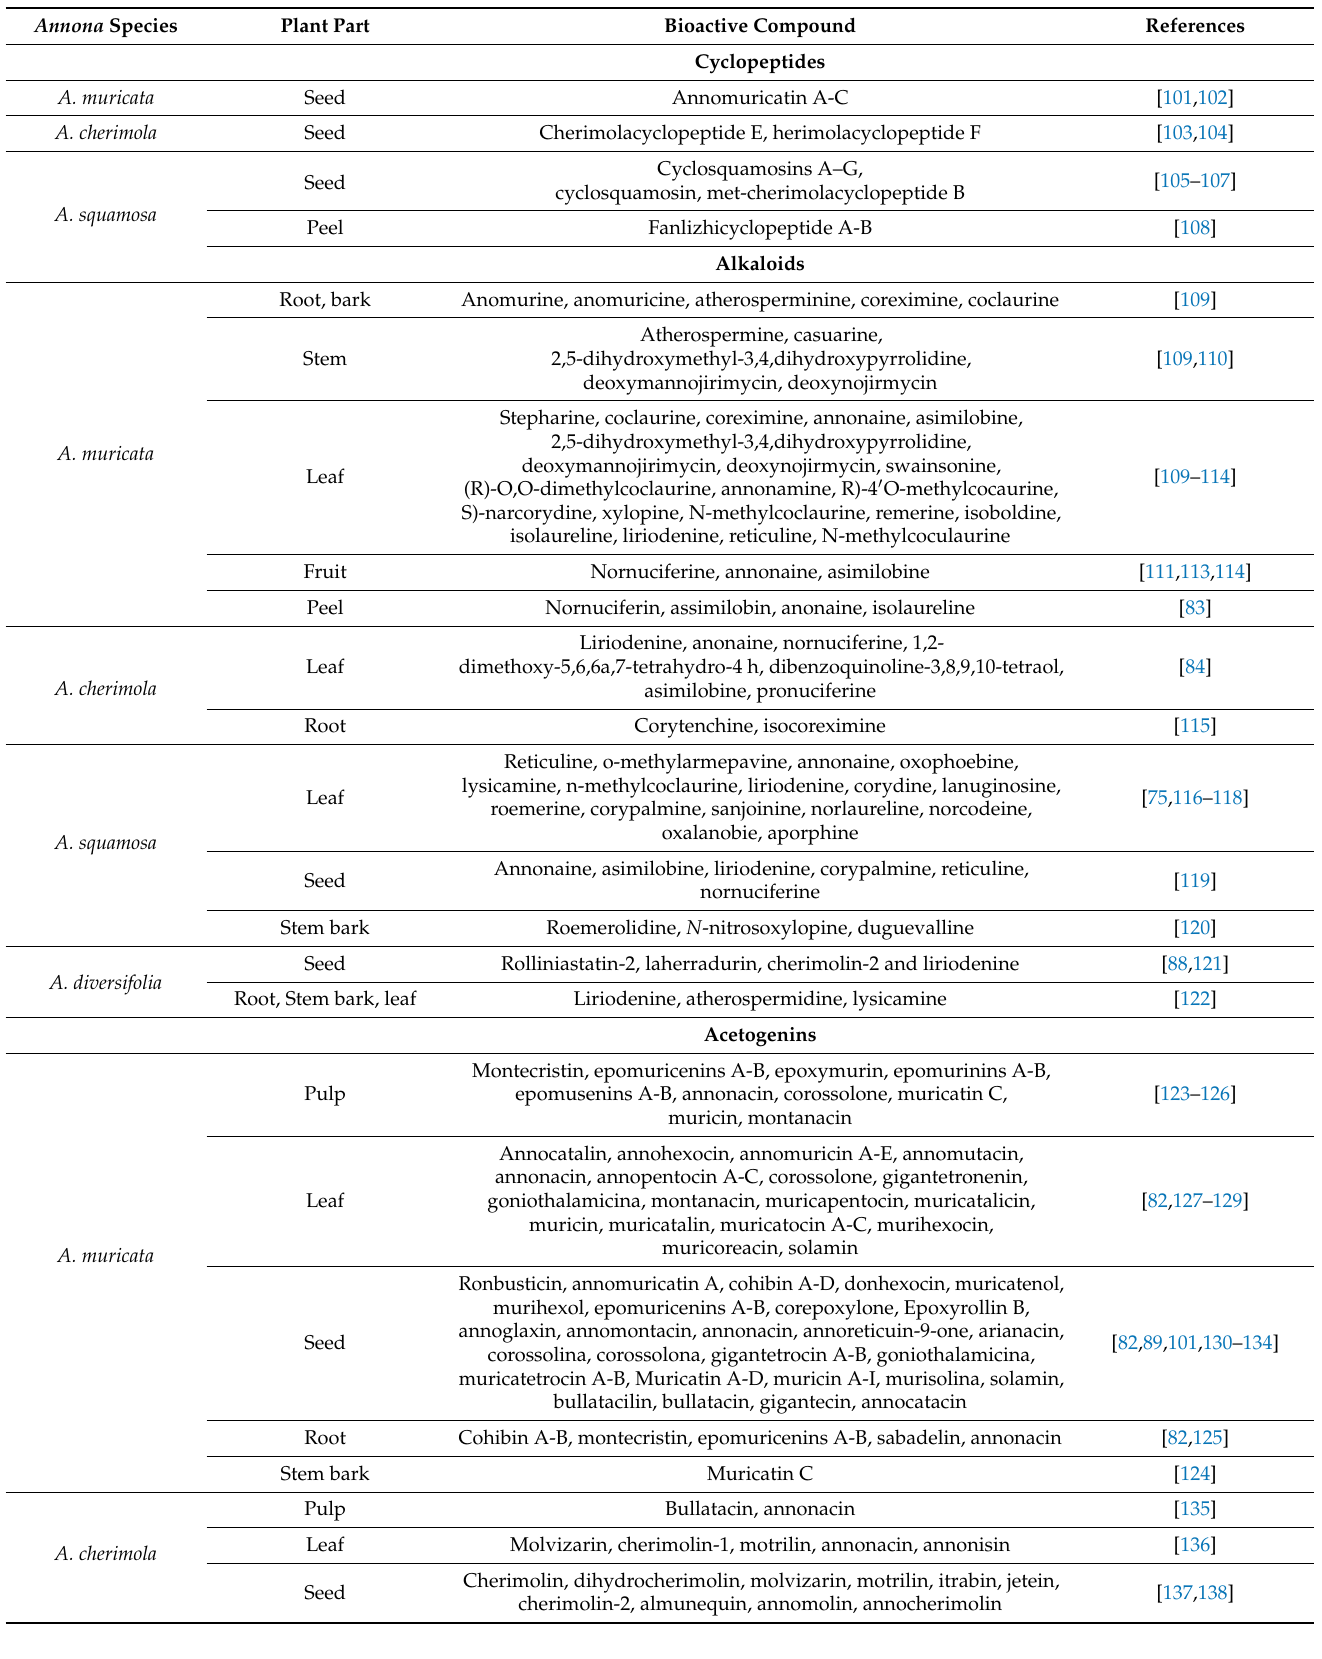
Table 3. Bioactive compounds: cyclopeptides, alkaloids, and acetogenins from different plant components of some Annona